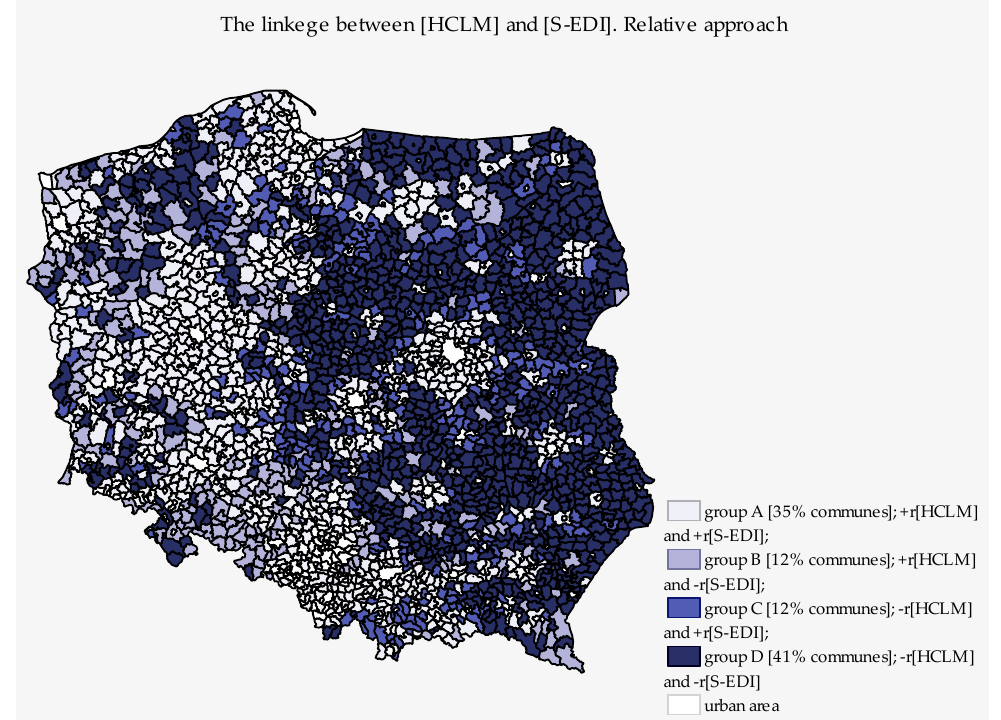
Figure 8. Linkage between the level of human capital in the area of the labor market [HCLM] and the level of socio-economic development [S-EDI]. Source: own elaboration.